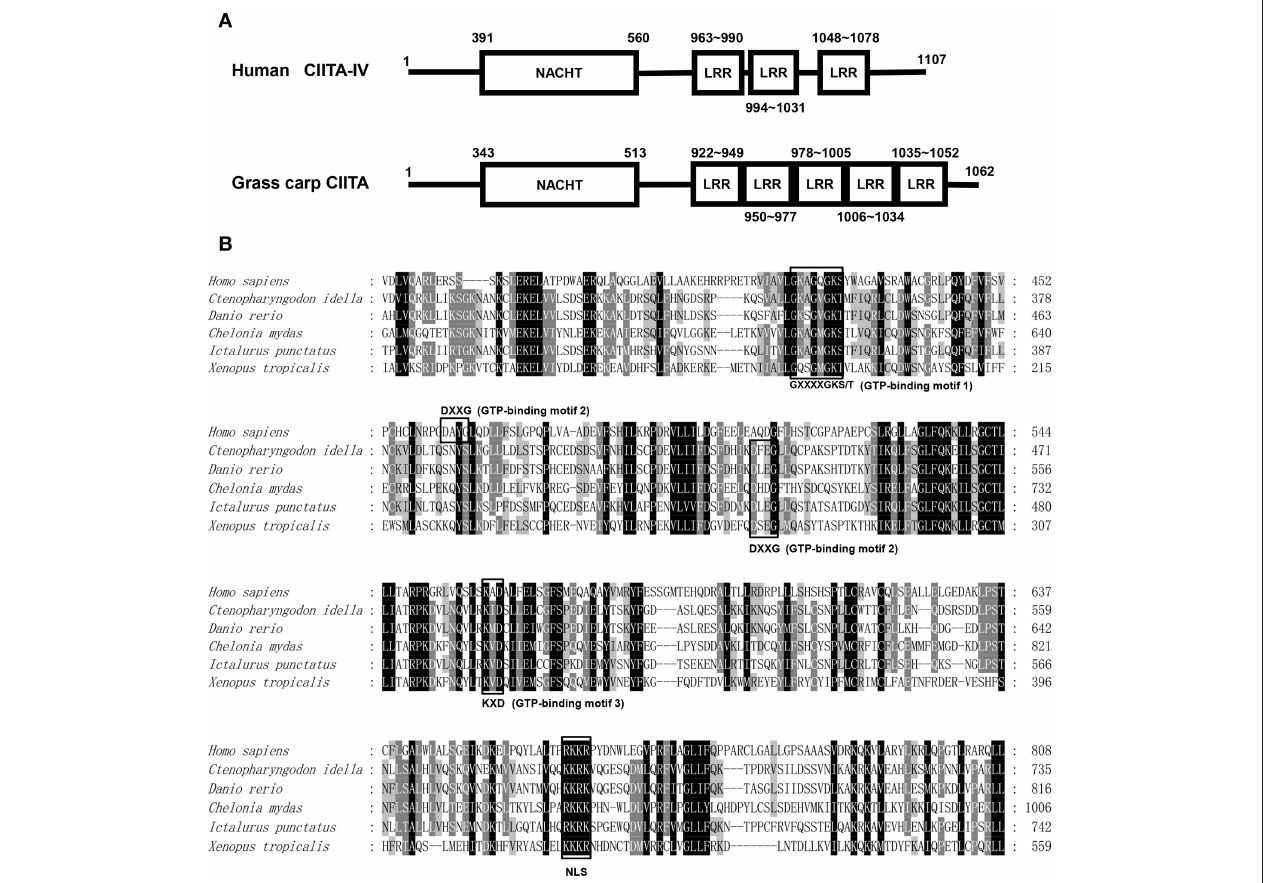
FIGURE 2 | Protein sequence analysis of the CIITA. (A) NACHT domains and LLR domains of human and grass carp CIITA were identified with Smart BLAST in NCBI (https://www.ncbi.nlm.nih.gov/). (B) GTP-binding motifs and NLS were identified by the characteristic sequence analysis reported in human. The accession numbers of CIITA included in amino acid sequence alignment are as follows: Homo sapiens , NP_001273331; Chelonia mydas , XP_007058212; Xenopus tropicalis , XP_017952759; Ictalurus punctatus , AFL70283; Danio rerio , XP_009297712; Ctenopharyngodon idella , AXY05349.